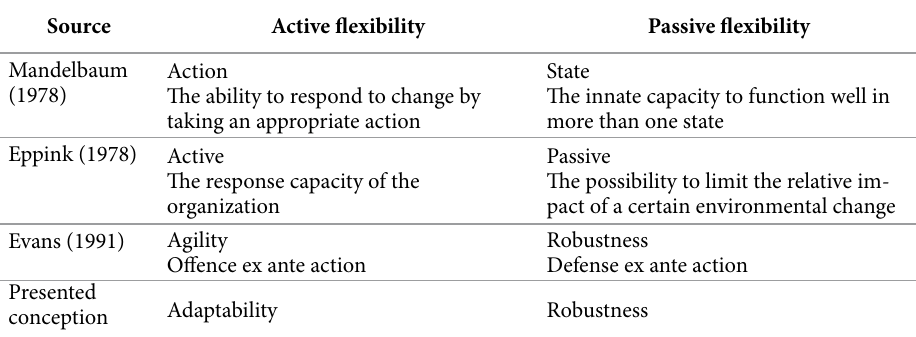
Table 1. Two kinds of